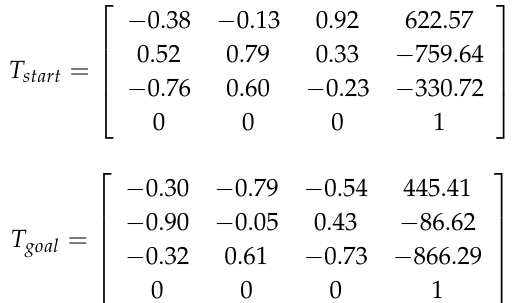
The yellow circle dots represent the initial position and the end position for the manipulator.